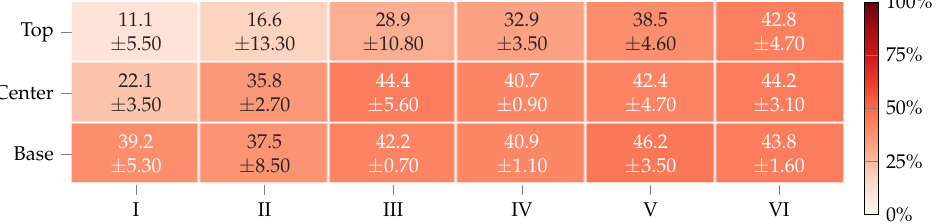
Figure 10. Average FVC and standard deviations of three different samples molded with process Configuration B are analyzed via thermal gravimetric analysis. The partitioning follows the illustration in Figure 1b, where the red dotted lines indicate the separation between top, center and base of the